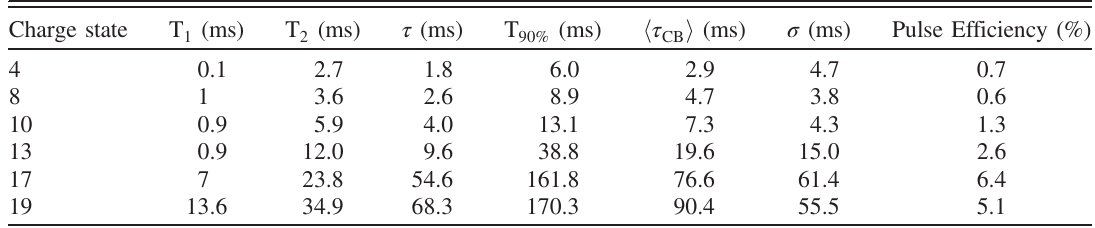
TABLE III. Characteristic N þ pulse temporal parameters as a function of Rb ion charge state. Charge